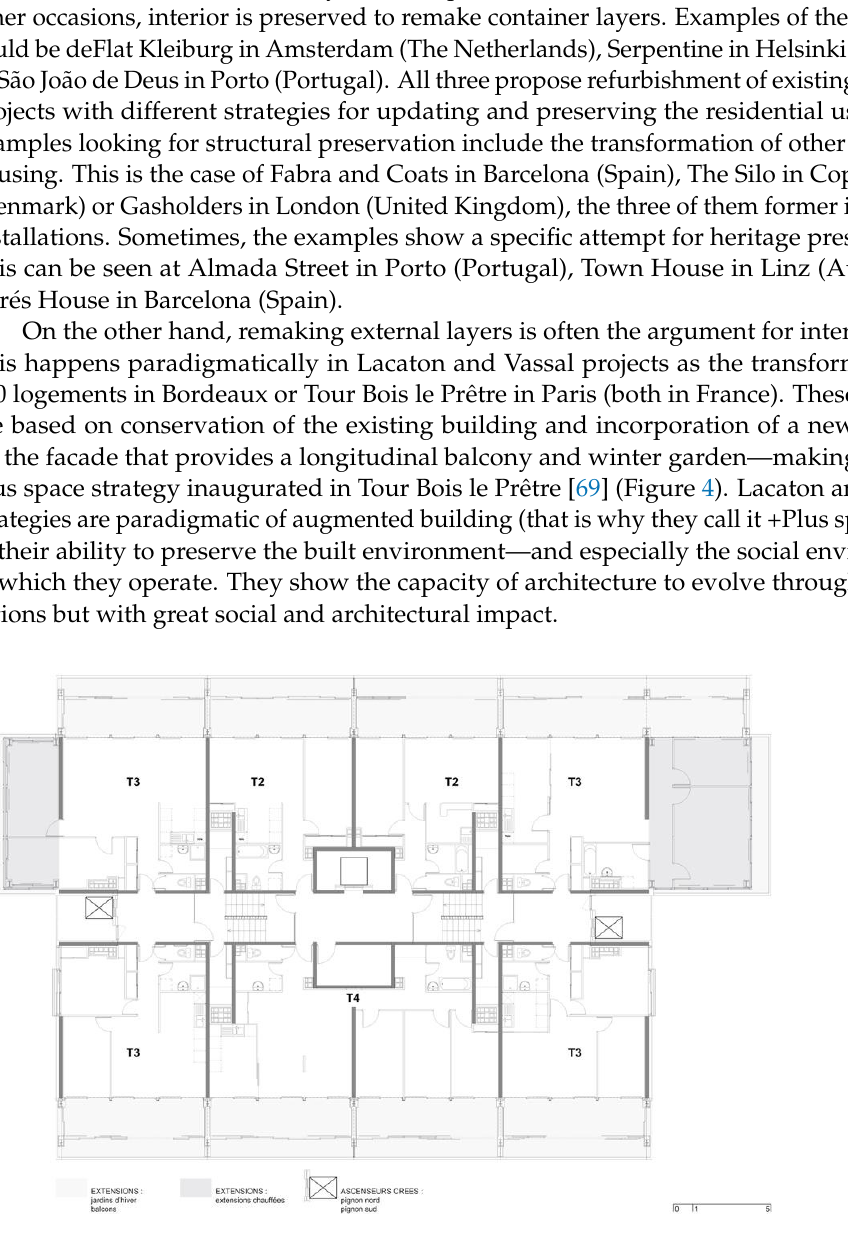
Figure 4. Transformation of Tour Bois-le-Prêtre Housing Block. EU Mies Award Archive. https://eumiesaward.com/work/1594 (accessed on 8 February 2021).